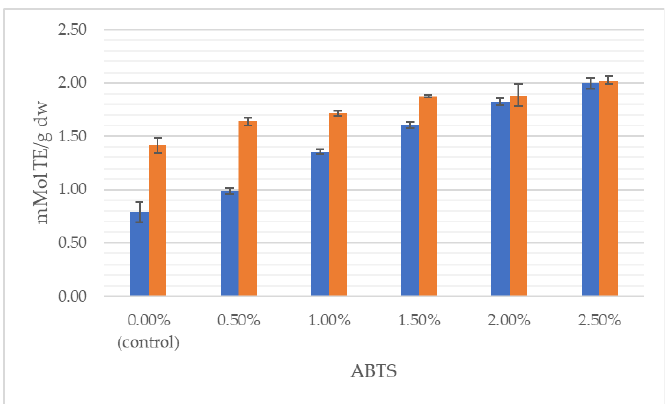
Figure 2. Total polyphenol content (TPC) of wheat dough (blue bars) and bread (orange bars) enriched with J. regia male flowers.